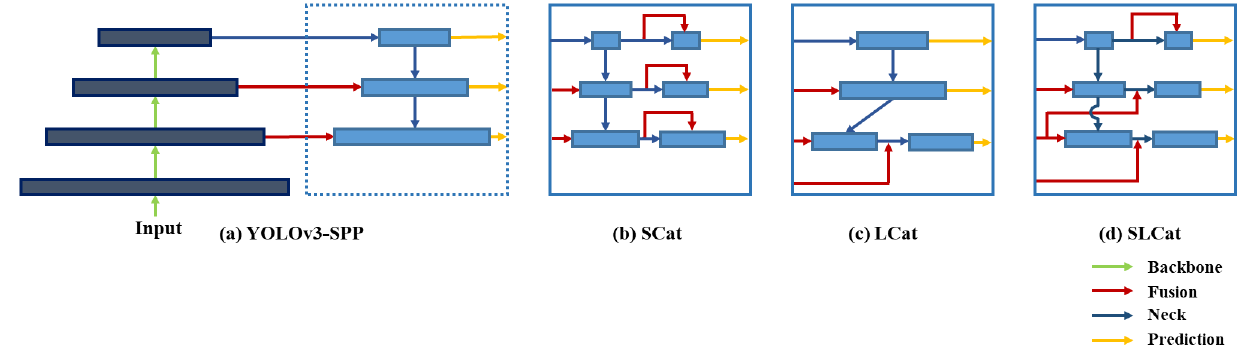
Figure 4. Different feature concatenation strategies. ( a ) YOLOv3 with Spatial Pyramid Pooling mod- ule. ( b ) Short-skip Concatenation. ( c ) Long-skip Concatenation. ( d ) Short-Long-skip